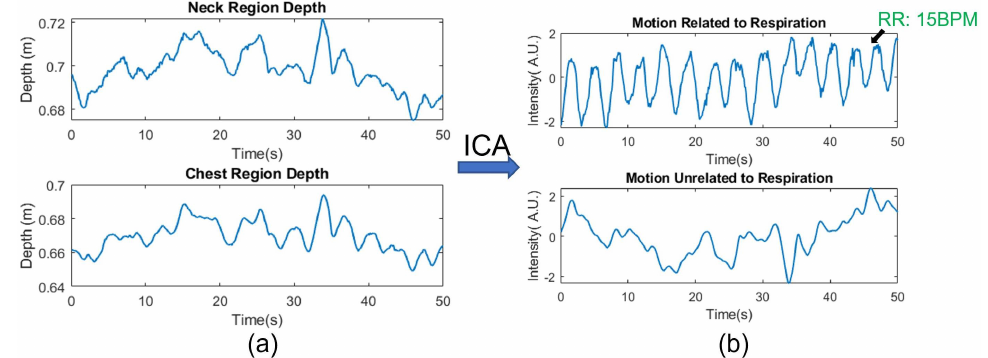
Figure 20. ( a ) Time domain signal for RR extraction: Raw depth signal from neck region not containing RR motion (top), raw depth signal from chest region containing RR motion (bottom). ( b ) Depth signal after ICA separation: Signal component with RR motion (top), signal component without RR motion compensation